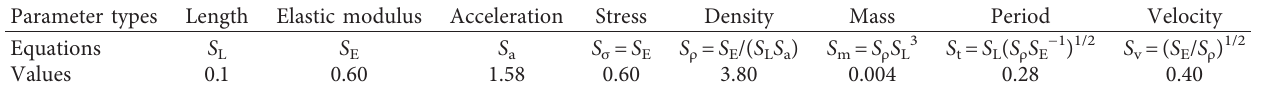
Figure 1: Deformation and damage of the steel-concrete hybrid structure. (a) Conventional hybrid structure. (b) Hybrid structure with BRBs. Table 1: Similarity coefficients of the